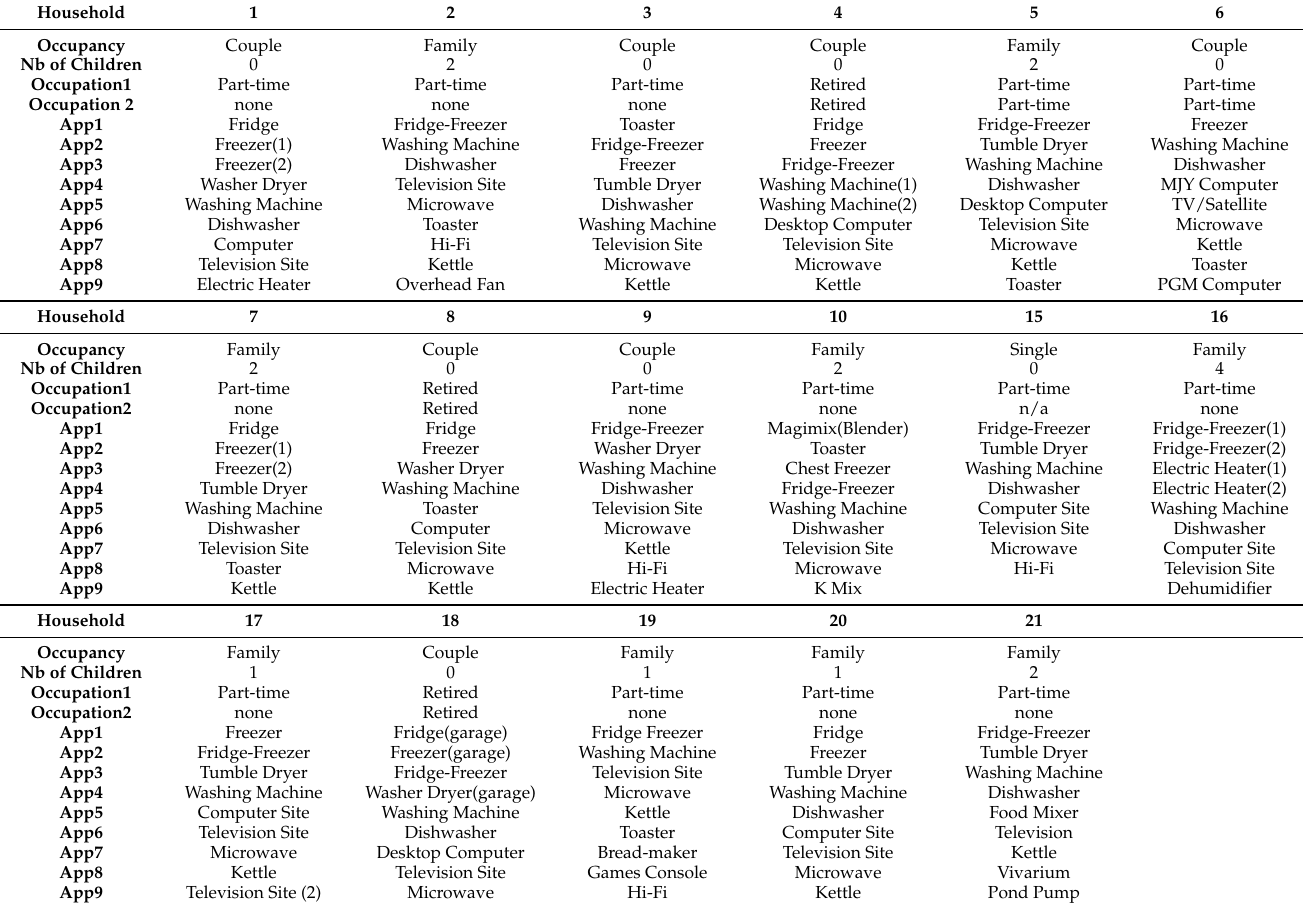
Table 4. Household data including occupancy, occupations, children, and appliance types.